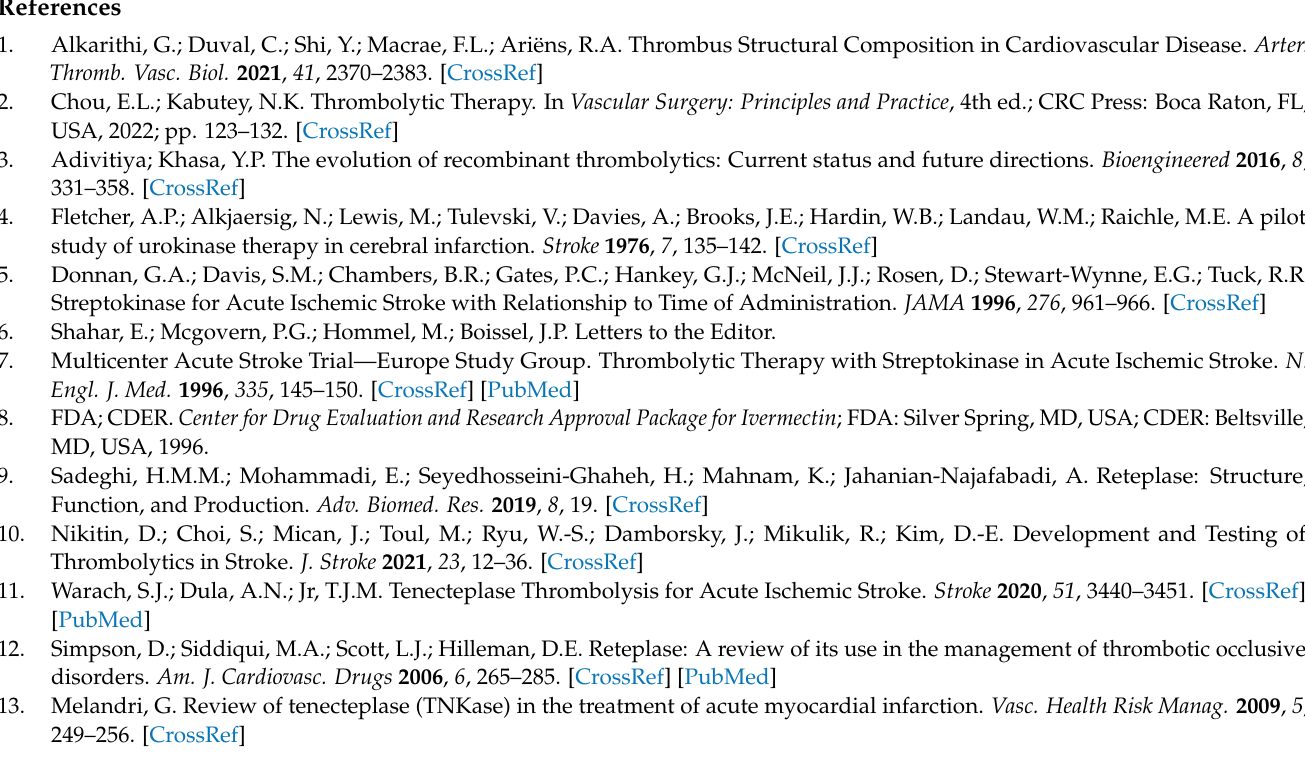
Figure A3. Comparison between simulation results and clinical results from Joerg et al. [31].